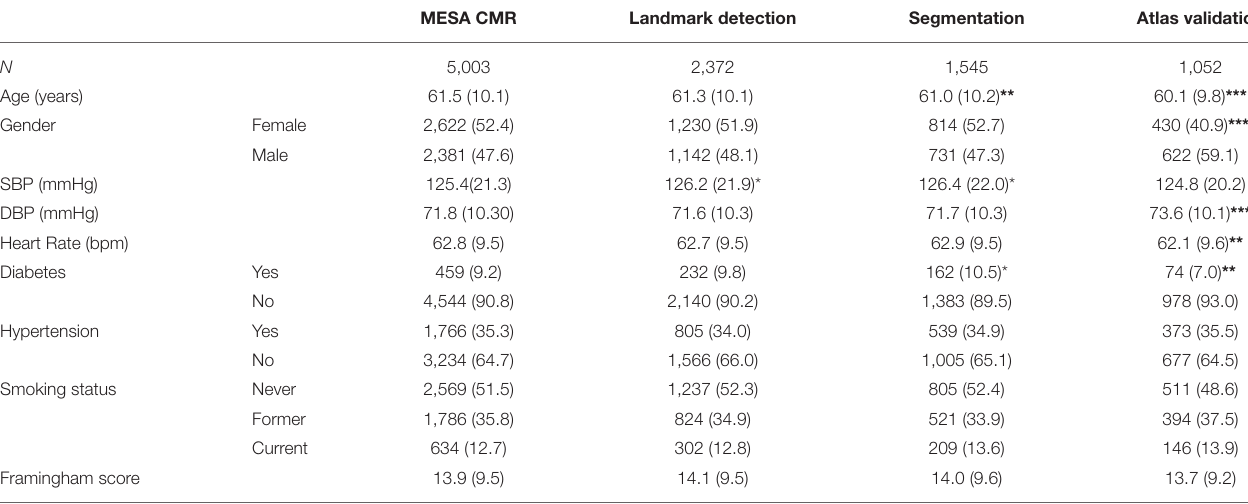
TABLE 1 | Patient demographics from the MESA cohort. MESA CMR Landmark detection